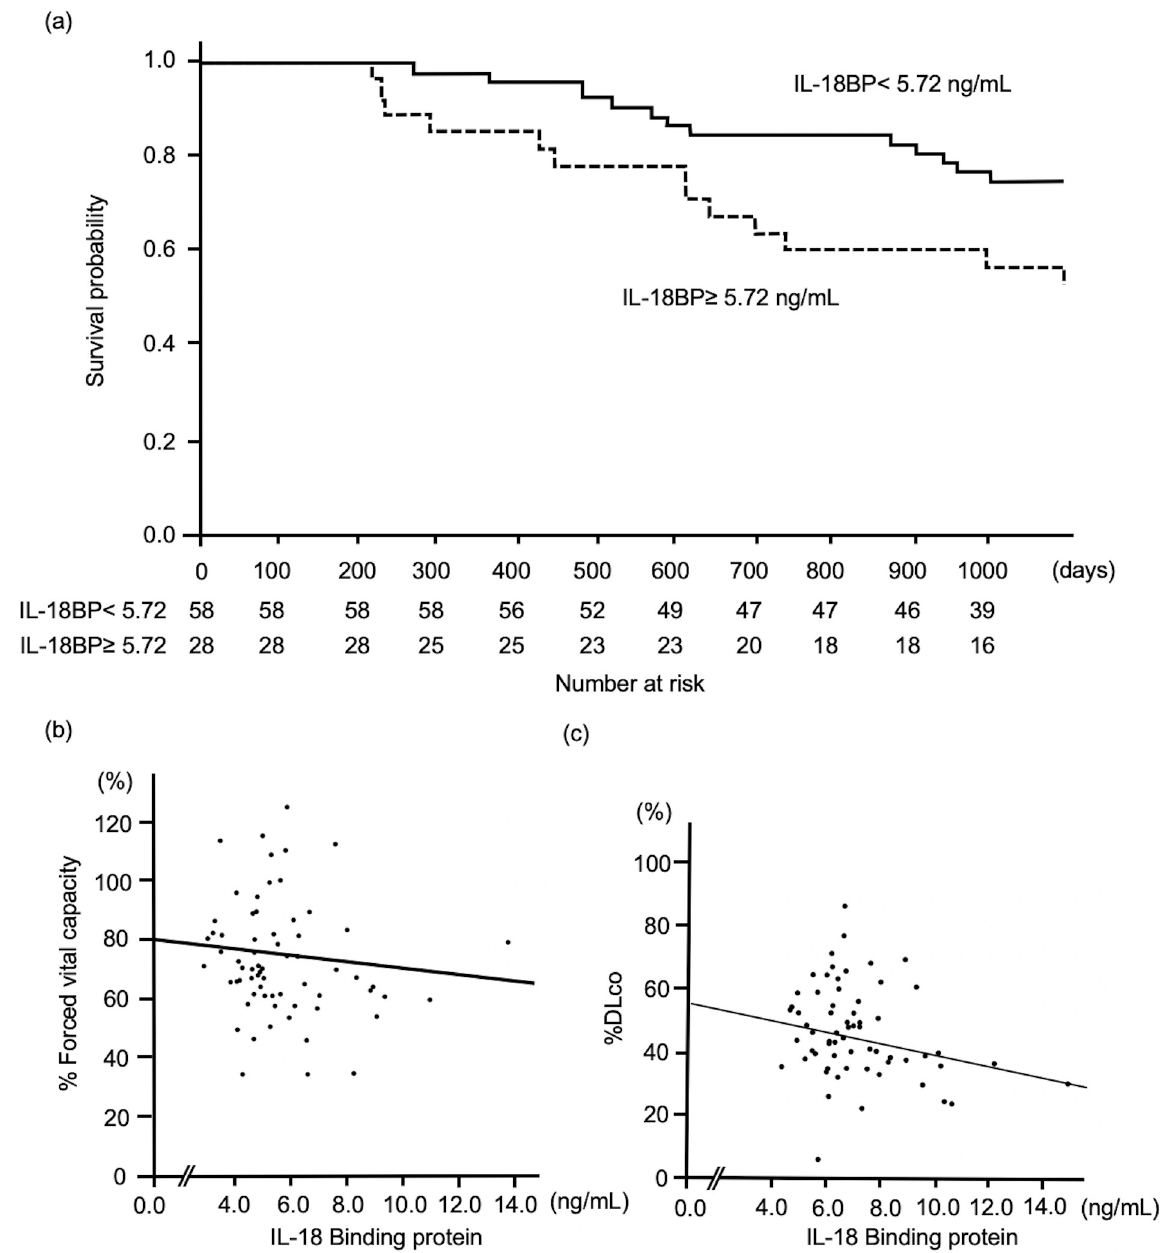
Fig 3. Correlations between serum IL-18BP levels and pulmonary function or survival outcome of patients with IPF. (a) Kaplan–Meier analysis for 3-year survival in patients with IPF, based on serum IL-18BP levels. Patients with higher levels of serum IL-18BP ( � 5.72 ng/mL) showed significantly poorer survival compared with those with lower serum IL-18BP ( < 5.72 ng/mL). (b) Scatter plot graphs showing the correlations between serum IL-18BP levels and %FVC, which showed no significant correlation (Spearman r = -0.177, p = 0.156). (c) Serum IL- 18BP levels showed significant negative correlations with %DLco (Spearman r = -0.300, p = 0.016). IL-18BP: interleukin-18 binding protein, IPF: idiopathic pulmonary fibrosis, FVC: forced vital capacity, DLco: diffusion capacity of the lung for carbon